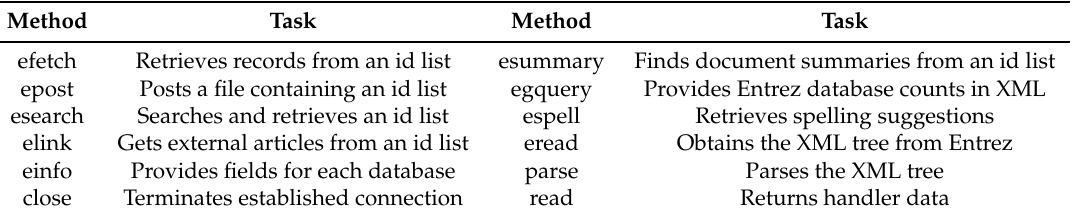
Table 3. Biopython